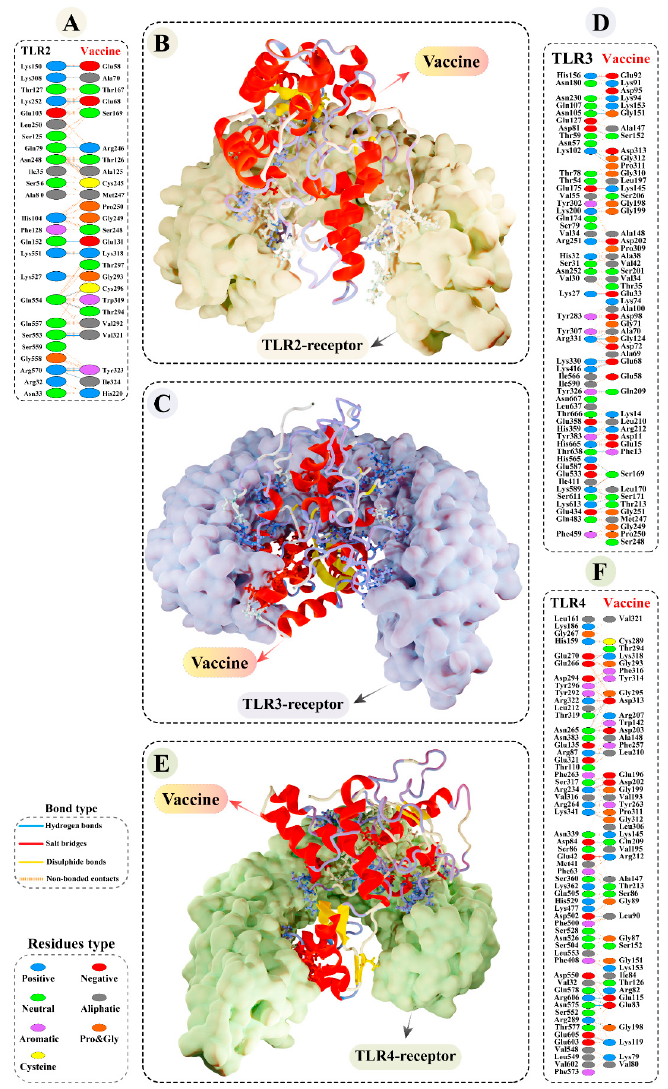
Figure 5. Molecular docking study of the modelled vaccine construct and Toll-like receptor (TLR2, TLR3, and TLR4). ( A ) Interface contacts between the putative vaccine construct and TLR2. Best binding confirmations of ( B ) modelled vaccine construct–TLR2 complex and ( C ) modelled vaccine construct–TLR3 complex. ( D ) Interface contacts between the modelled vaccine construct and TLR3. Best binding confirmation of ( E ) modelled vaccine construct–TLR4 complex. ( F ) Interface contacts between the modelled vaccine construct and TLR4. Hydrogen bonds are depicted in blue lines. The residue type is shown with a distinctive